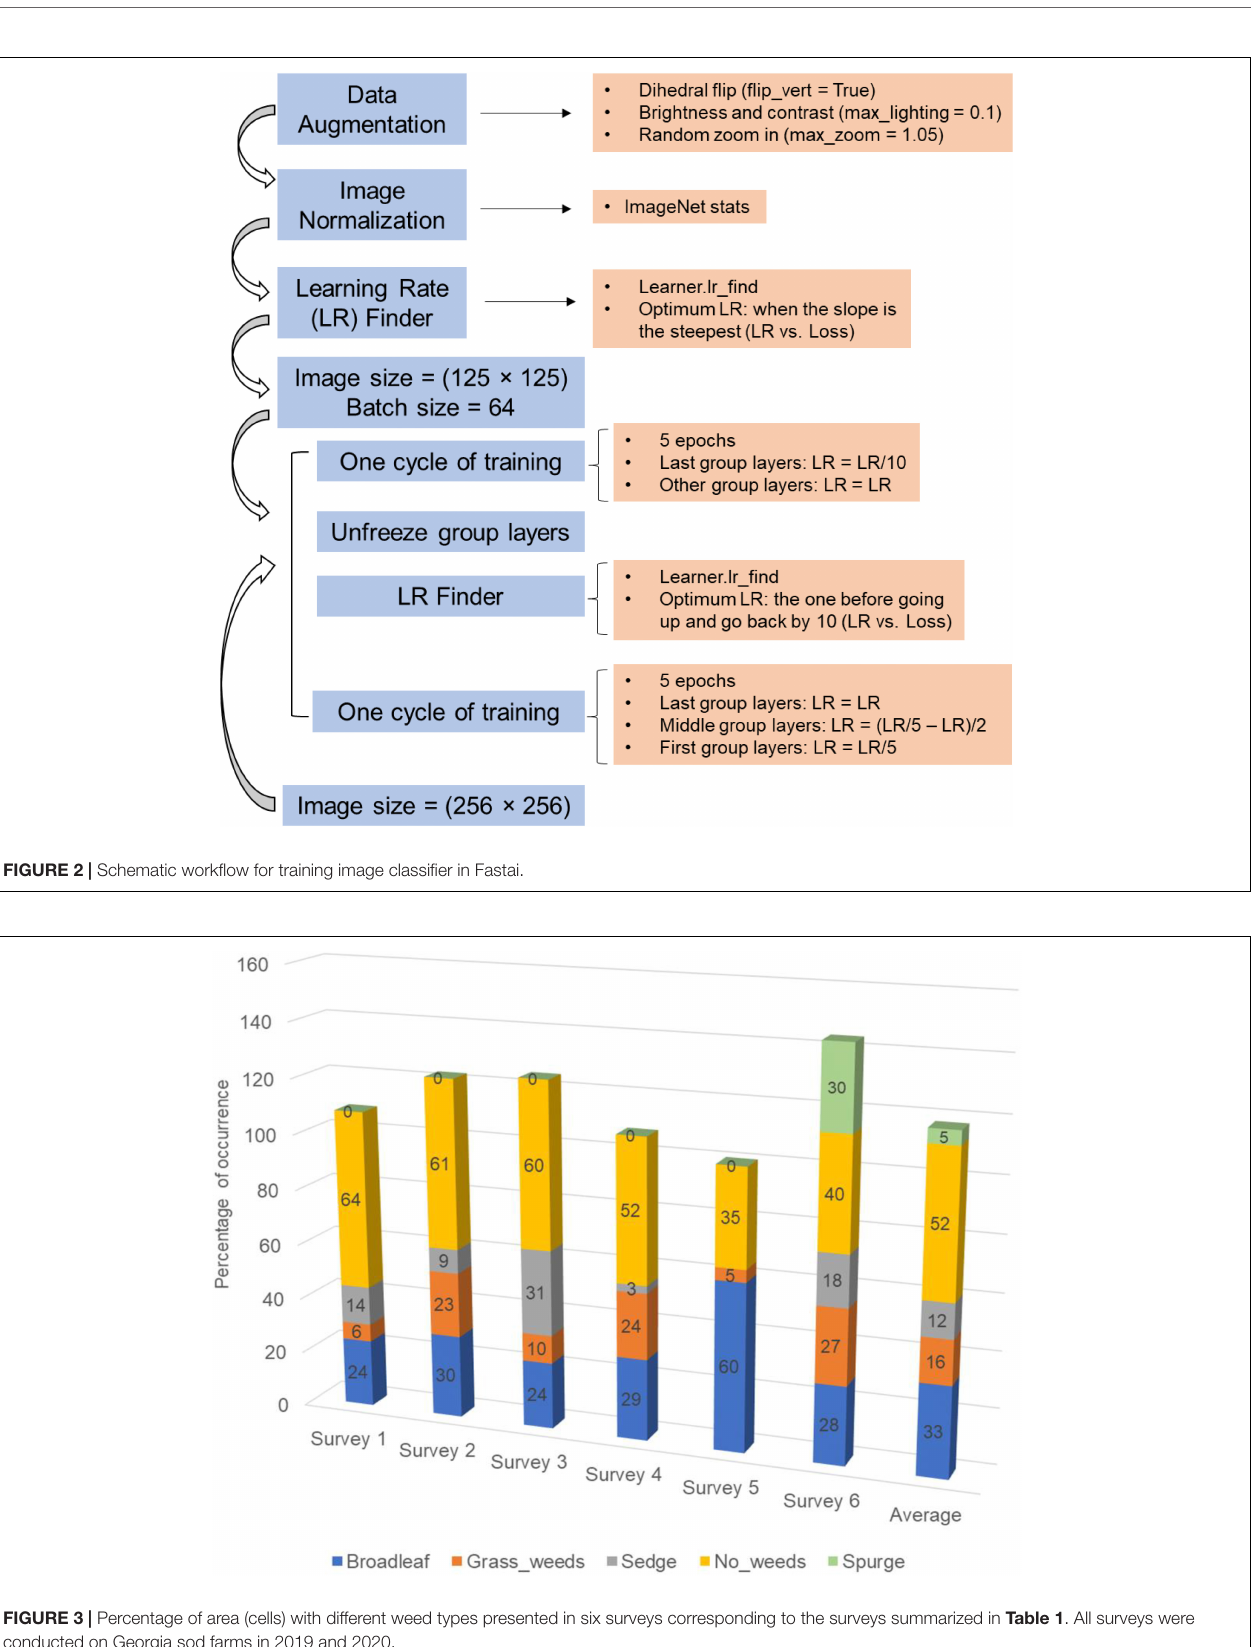
Frontiers in Plant Science |